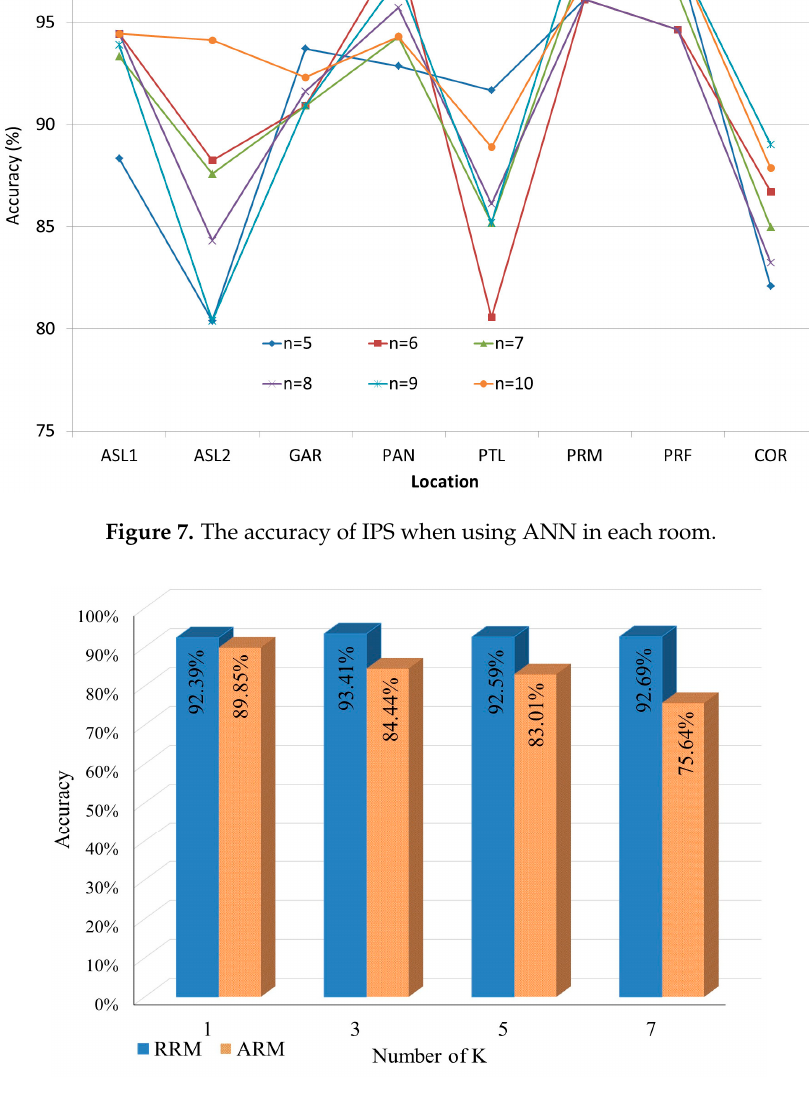
Figure8. KNN positioning result accuracy. Figure 8. KNN positioning result